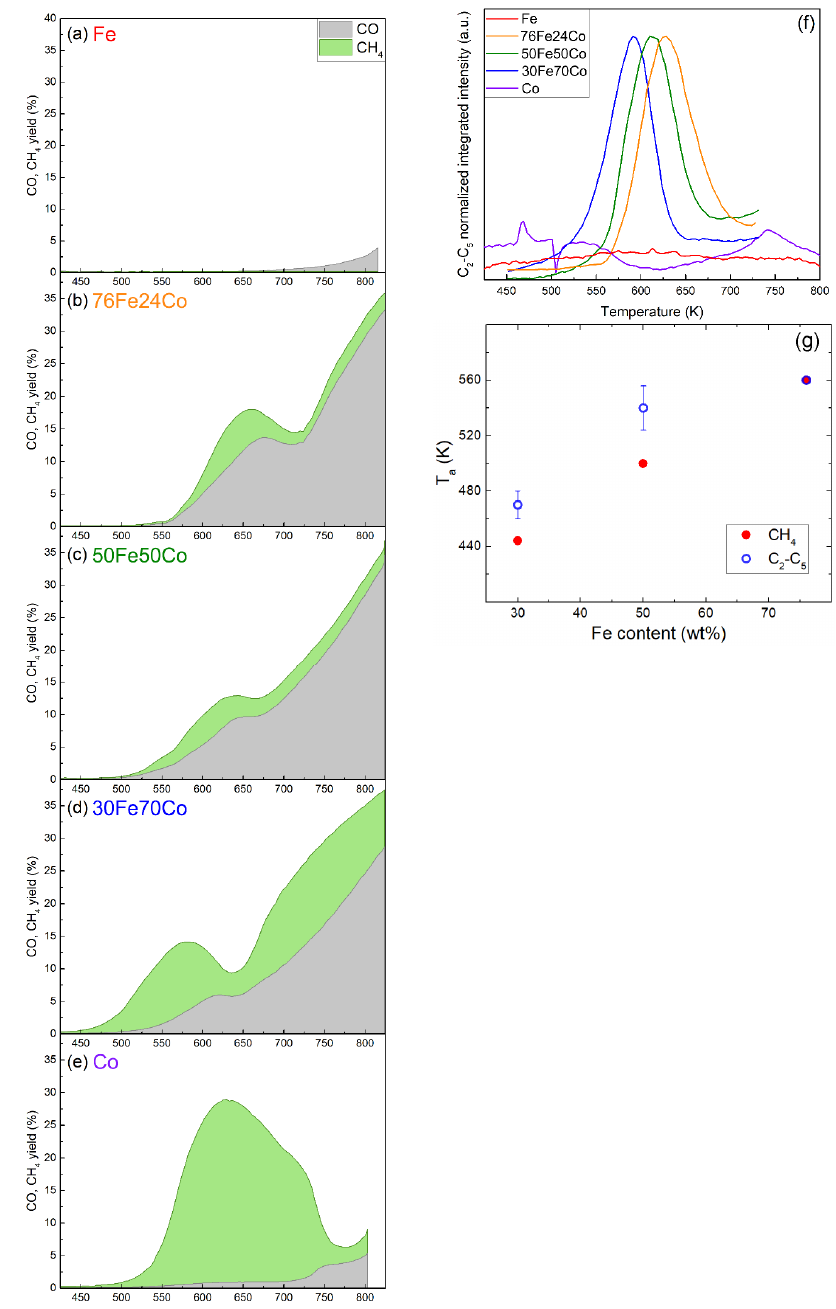
Figure 4. Catalytic properties of samples ( a ) Fe, ( b ) 76Fe24Co, ( c ) 50Fe50Co, ( d ) 30Fe70Co, ( e ) Co in a flow reactor with 4:1 H 2 :CO 2 ratio, 1 bar and 10 mL n min − 1 , measured by mass spectroscopy. The stacked area-filled plots show the total CO 2 conversion with the separated contributions of CO yield in grey and CH 4 yield in green; ( f ) conversion of CO 2 into C 2 -C 5 HCs obtained semi-quantitatively by summing the normalized MS signals for m / z = 26, 29, 30, 39, 56, 57, and 70; ( g ) activation temperature T a of the nanoalloy catalysts for CH 4 and C 2 -C 5 production as function of their Fe content. The error bars represent the standard deviation in the activation temperatures of the di ff erent C 2 -C 5 HCs, as detailed in Table